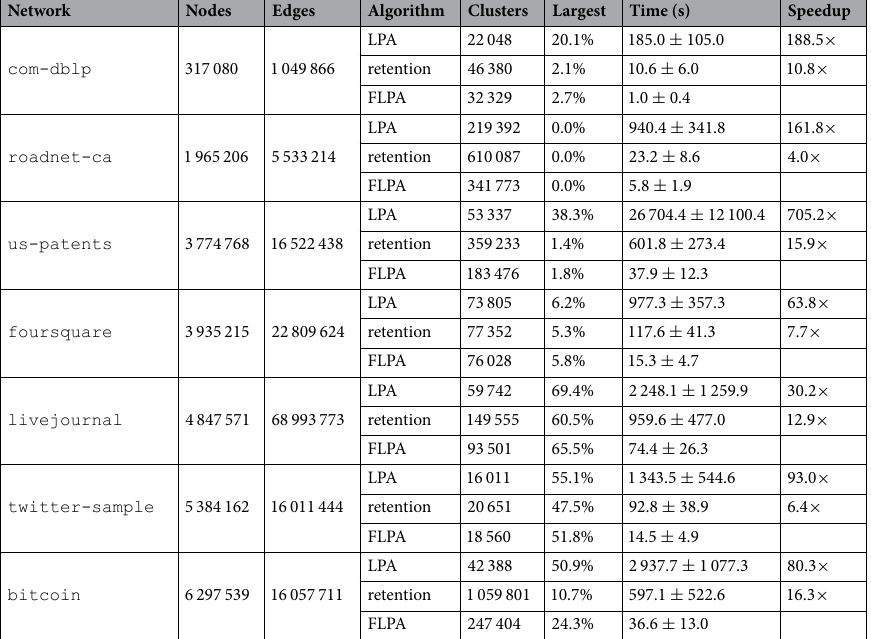
Table 2. Speedup of fast label propagation for empirical networks. Results are averages over 2000 runs of the algorithms ( 1 986 runs for the bitcoin